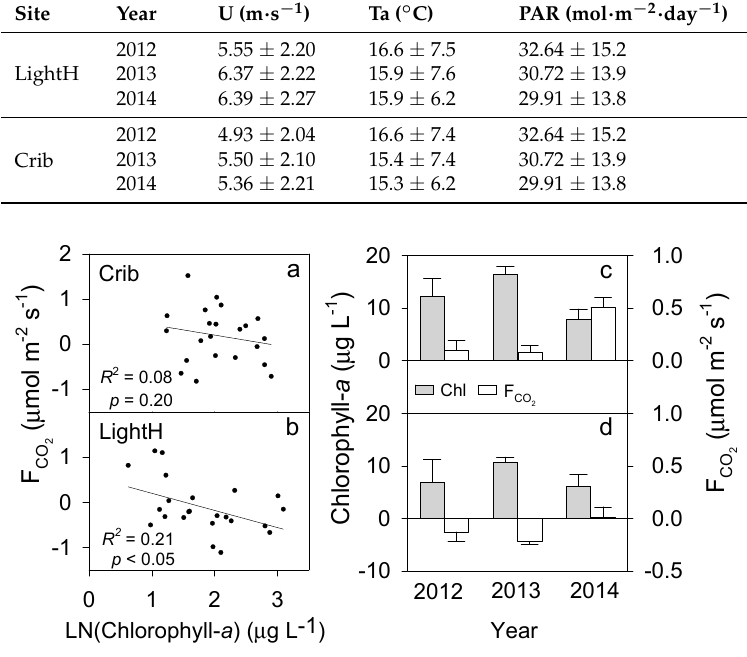
Figure 7. Changes in monthly mean chlorophyll-a during the study period at the Crib ( a ) and LightH ( b ) sites and inter-annual variations in mean chlorophyll-a (April–November) at the Crib ( c ) and LightH ( d ) sites.